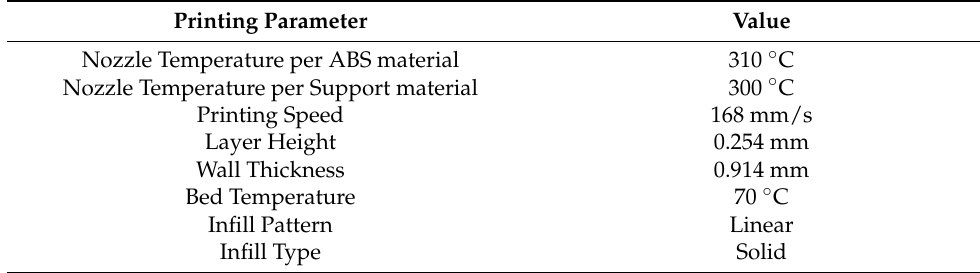
Table 1. Printing parameters utilized in this study. Printing Parameter